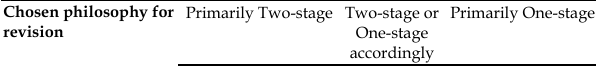
Table 3. Philosophy regarding chronic PJI requiring revision surgery.